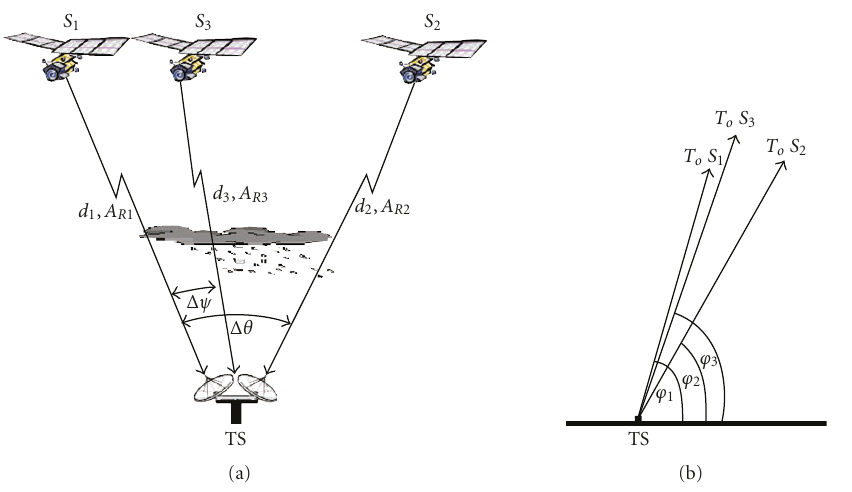
Figure 4: (a) Configuration of the satellite 2 × 2 MIMO diversity system assumed and the interference scenario on its forward link, (b) associated elevation